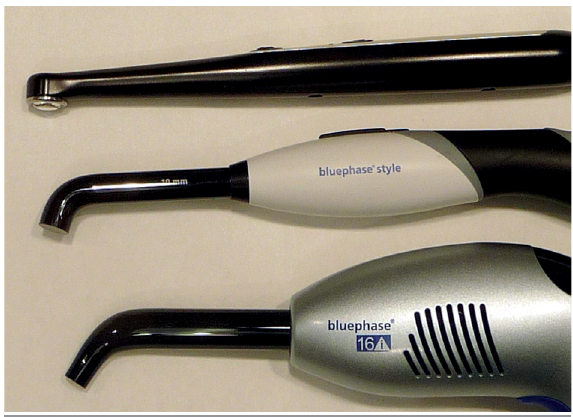
Figure 34. A variety of form factors of LED curing